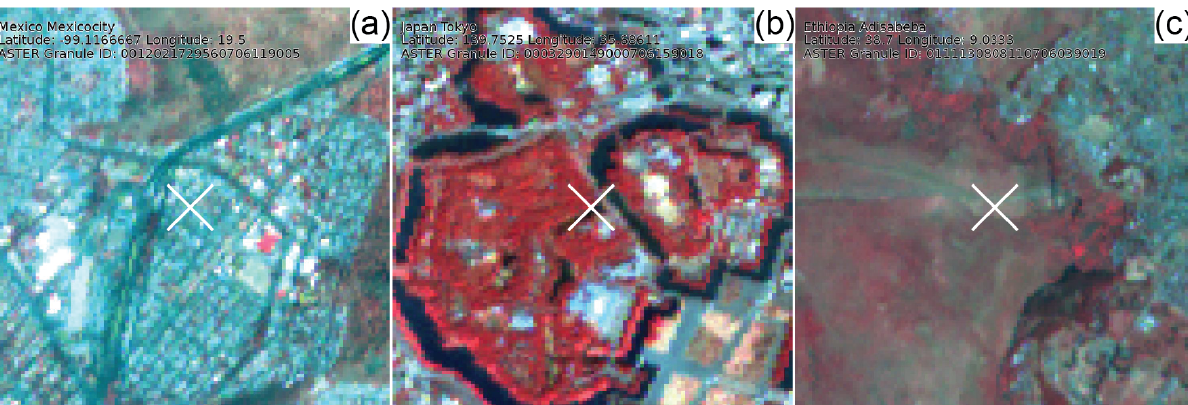
Figure 2. Examples of the visual interpretations of the point coordinates of cities using the ASTER/VNIR false colour composite images. The white cross represents the coordinates of the point data. (a) The location at the point coordinate for Mexico City (Mexico) was interpreted as urban. (b) The location at the point coordinate for Tokyo (Japan) was interpreted as non-urban. (c) The location at the point coordinate for Addis Ababa (Ethiopia) was interpreted as